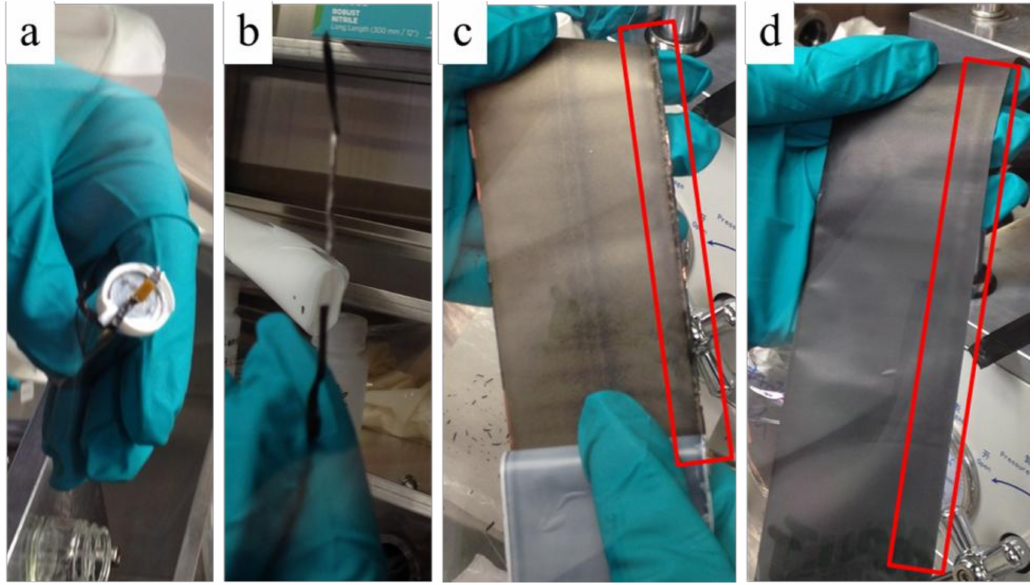
Figure 8. Images taken of the RE cell after electrical characterization and testing. The top of the cell after the cap has been removed as shown in ( a ), the reference electrode after testing is shown in ( b ). The red boxes indicate visual changes observed at the negative electrode ( c ) and the positive electrode ( d ) is furthest from the cell top